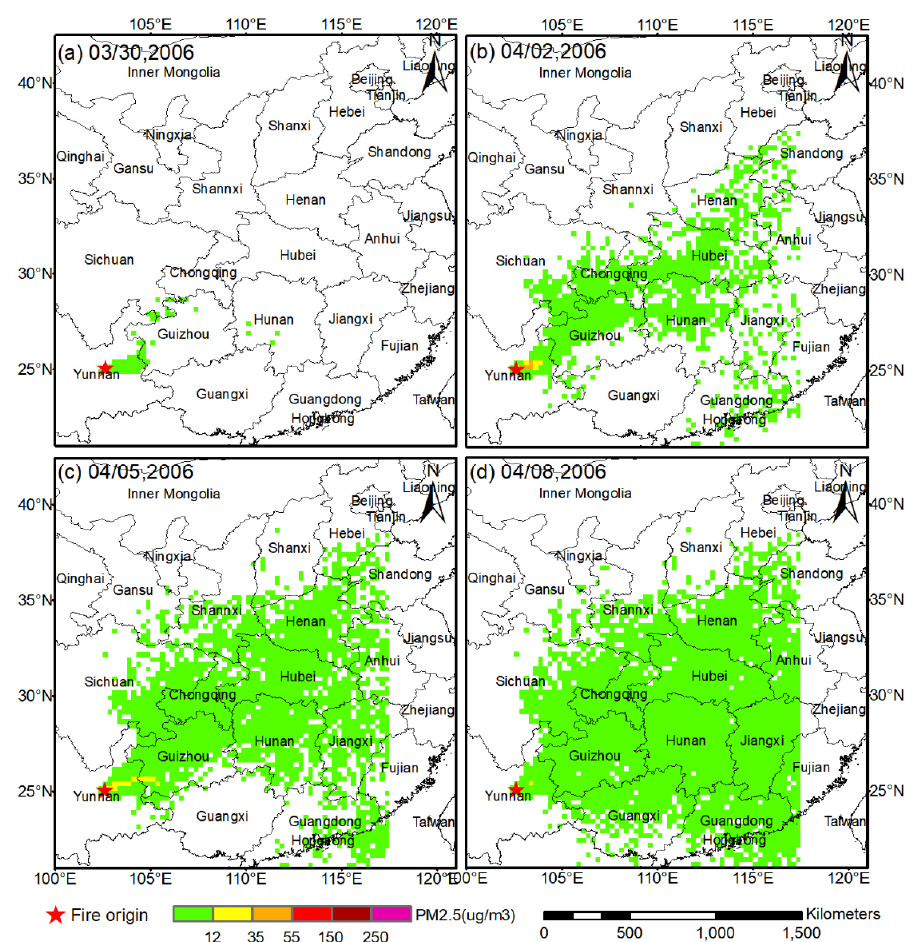
Figure A8. Same as Figure A1 except for the Anning fire. Panels ( a – d ) are 30 March and 2, 5, and 8 April 2006, respectively.